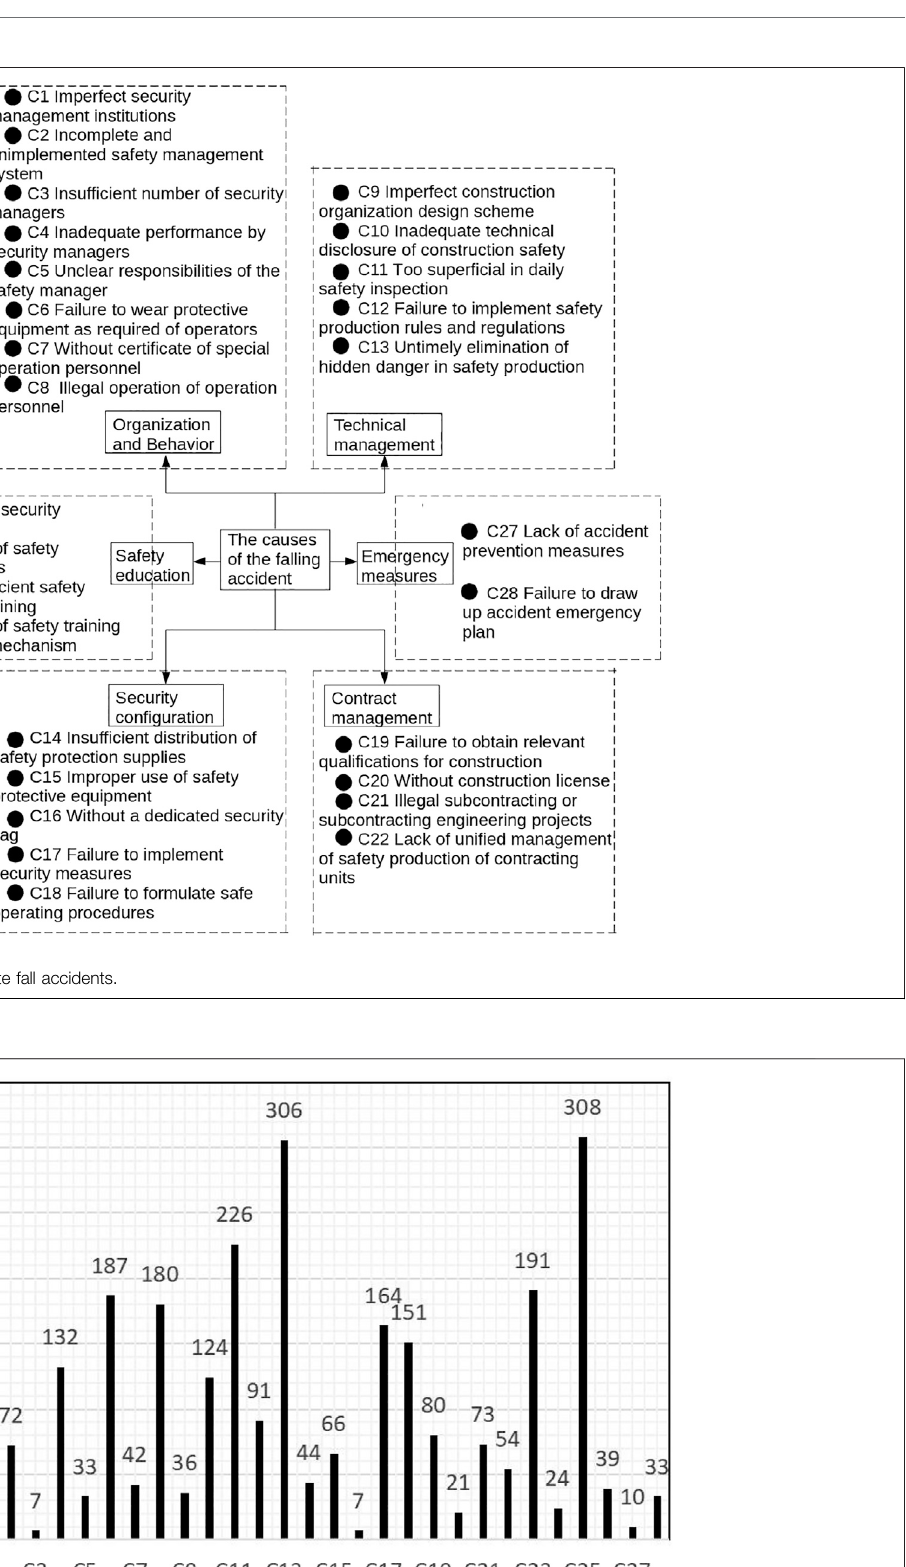
Frontiers in Built Environment |